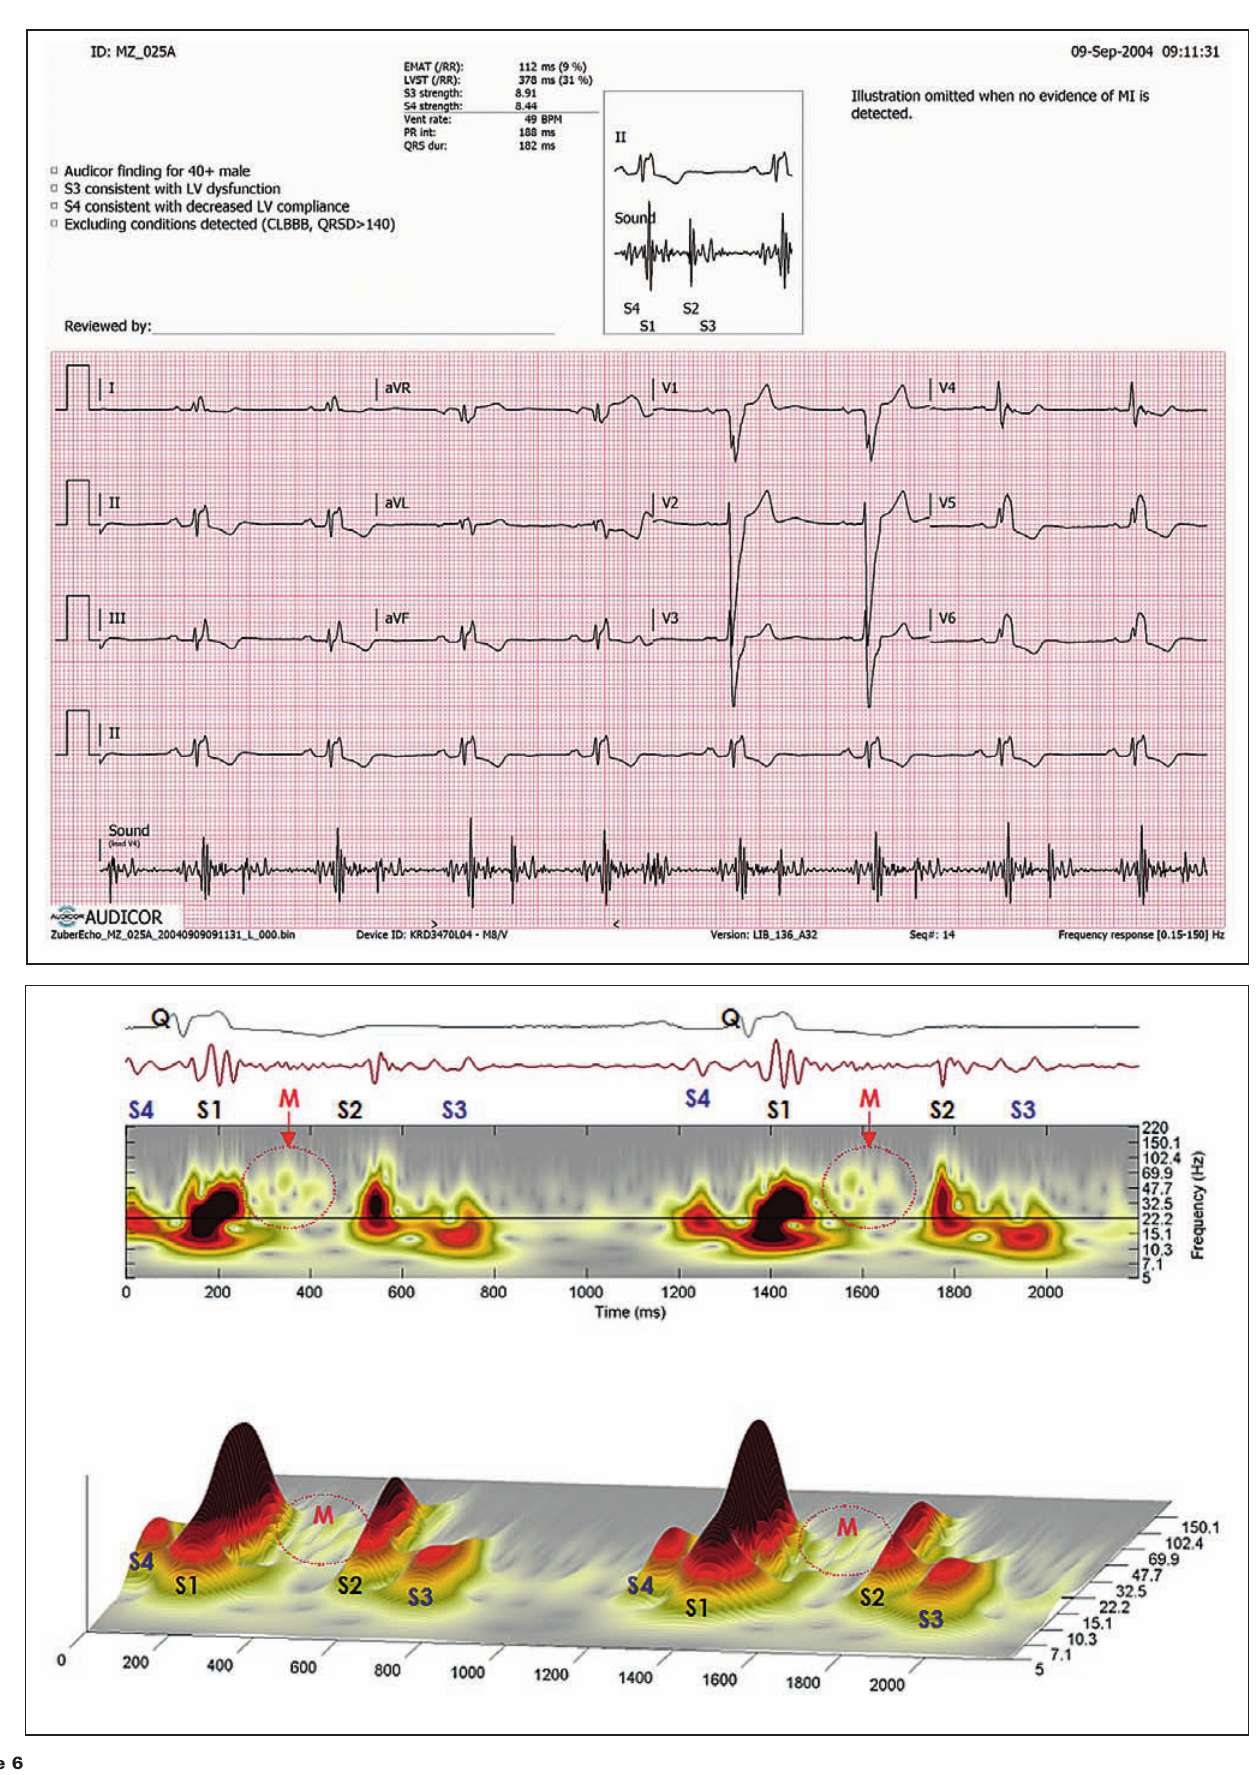
Figure 6 Acoustic cardiography report and time-frequency analysis of heart sounds for a subject with a systolic murmur. The upper panel (a) shows an acoustic cardiography report for a subject with a systolic murmur and the panels below (b) illustrate the 2D and 3D scalogram views for a few beats from the acoustic cardiography rhythm strip shown above. Since murmurs have higher frequency components than diastolic heart sounds, they do not have to be high in intensity to be detected by the human ear. Thus in this case, it will be easier for the human ear to detect the murmur than the low frequency third and fourth heart